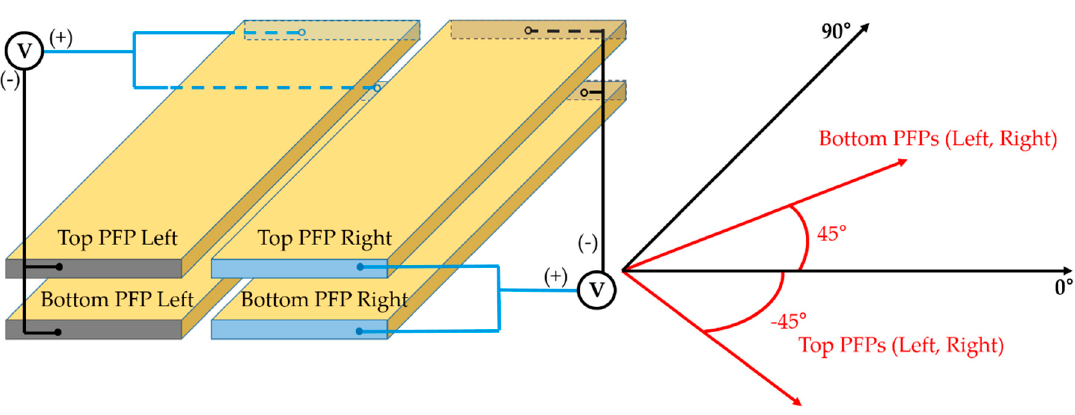
Figure 10. The schematic configuration of the homogenized dual SHPFP with its voltage boundary condition. The two voltage sources are exactly the same. The red arrows indicate the direction of the piezoelectric fibers and the rotated material property matrix of each homogenized PFP.